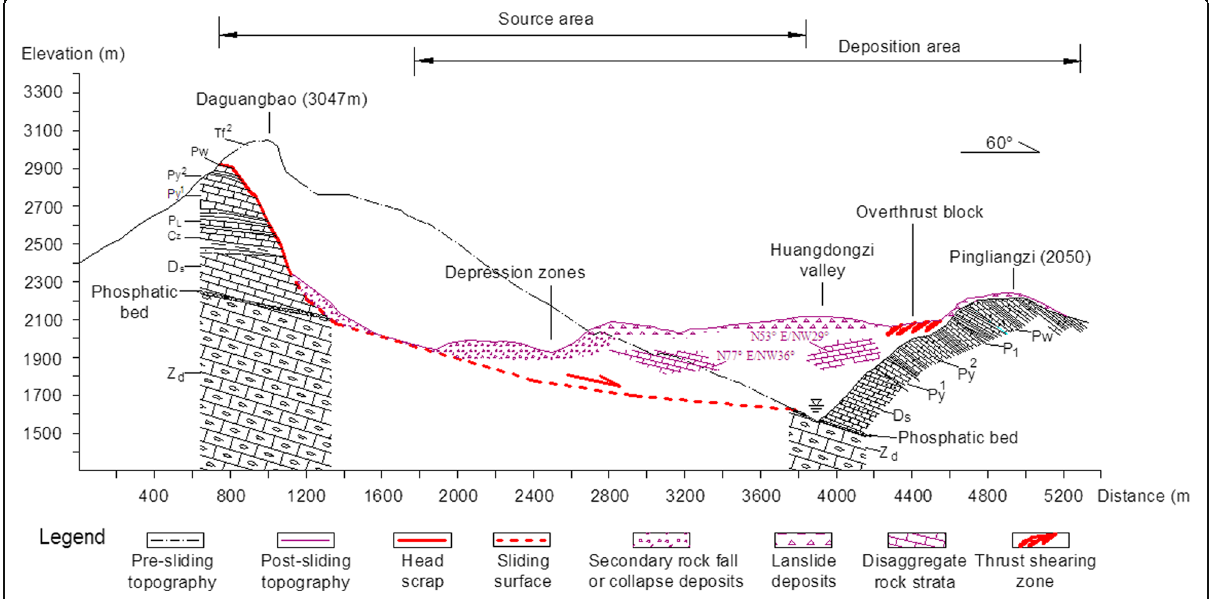
Fig. 4 Post-earthquake A-A ’ geological profile of the Daguangbao landslide, see Fig. 3 for the profile